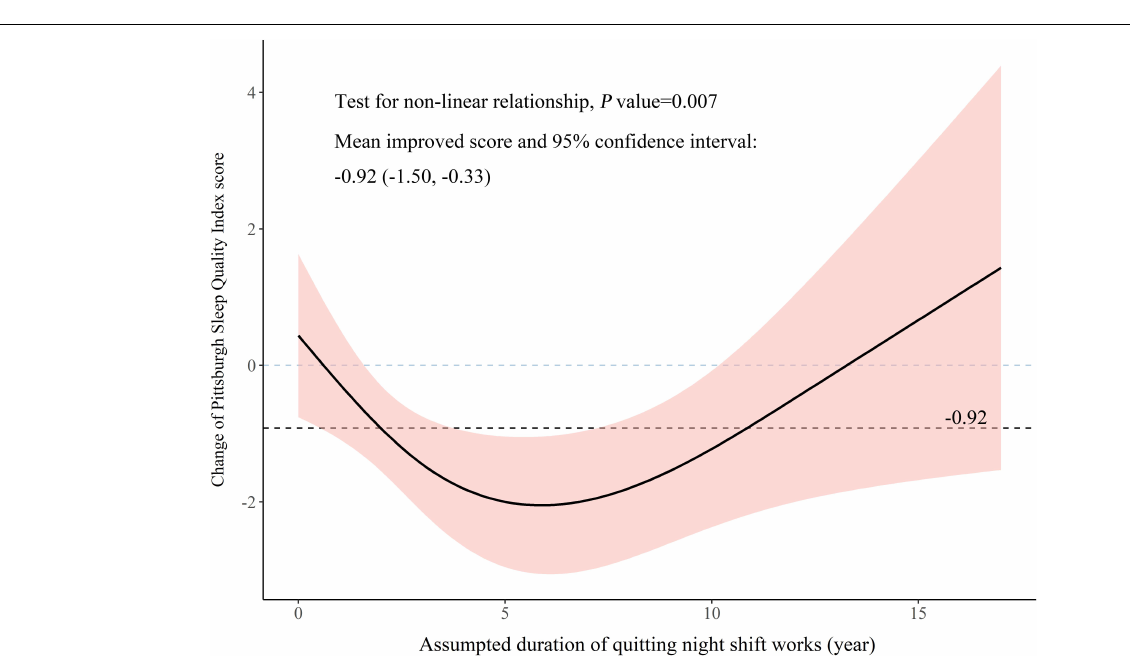
p = 0.007, see Figure 3 . After quitting night shift, change in PSQI score expanded gradually over about 6 years. Subsequently, the change reverted to 0. To present our results coherently and comprehensively, we connected the rising curve with a plateau and the U-shaped curve to form an S-shaped curve ( Figure 4